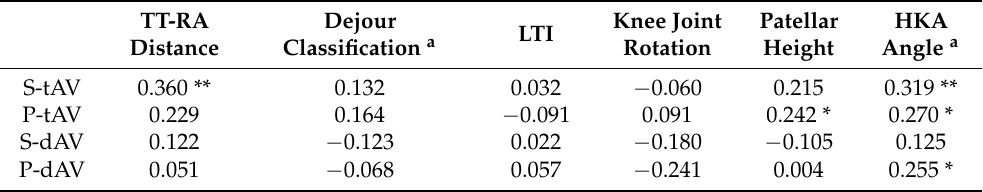
Table 3. Relation between the femoral torsion parameters and other anatomic parameters. TT-RA Dejour Distance